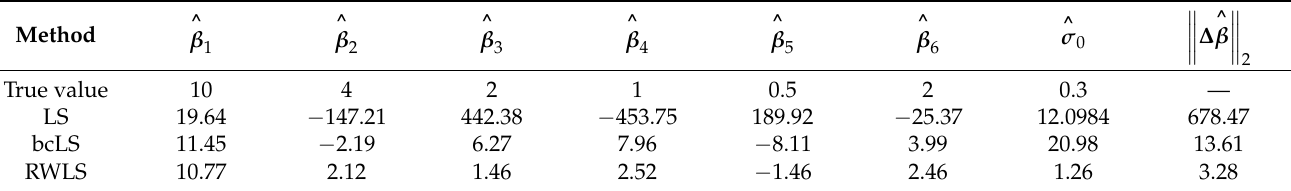
Table 5. Parameter estimation and accuracy.